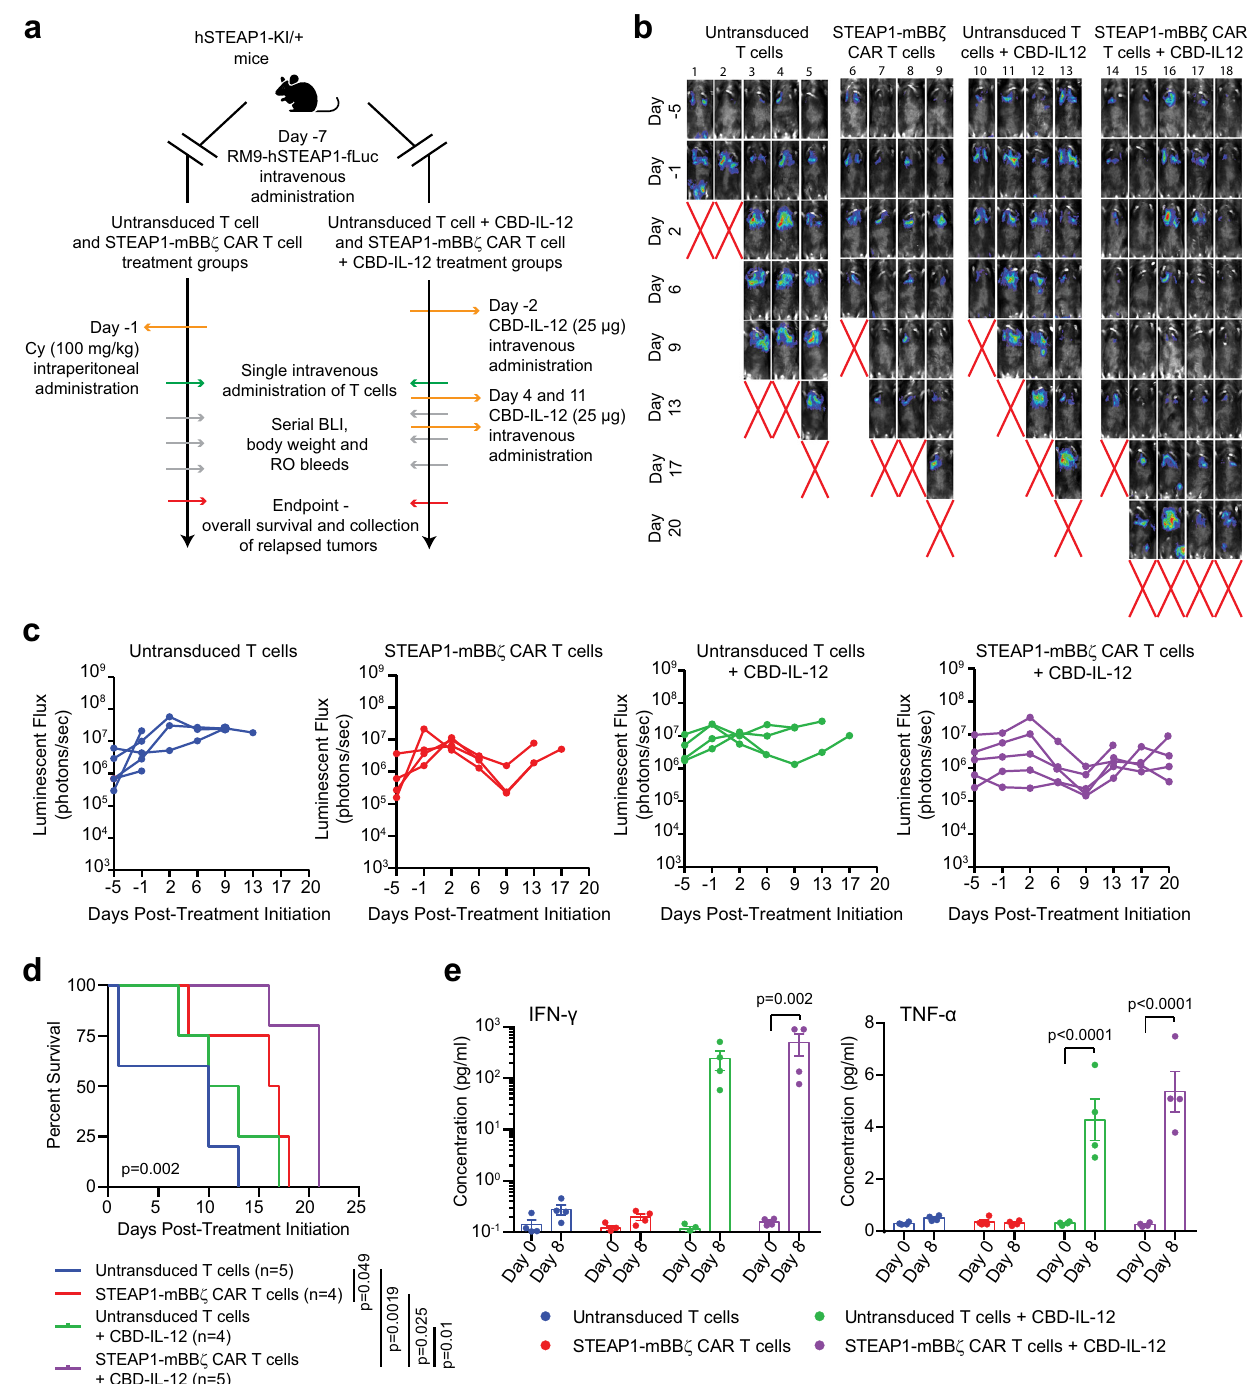
Fig. 7 | Combining CBD-IL-12 with STEAP1-mBB ζ CAR T cell therapy enhances overall survival and in fl ammatory cytokine levels. a Schematic of the tumor challenge experiment for the RM9-hSTEAP1 disseminated model in hSTEAP1-KI/+ mice investigating the combination of CBD-IL-12 with STEAP1-mBB ζ CAR T cell therapy. Cy cyclophosphamide (for preconditioning). Created with BioR- ender.com. b Serial live BLI of hSTEAP1-KI/+mice engrafted with RM9-hSTEAP1- fLuc metastases and treated with a single intravenous injection of 5×10 6 mouse untransducedTcellsorSTEAP1-mBB ζ CARTcellsonday0withorwithoutCBD-IL- 12treatmentweekly.RedXdenotesdeceasedmice.Theradiancescaleisshown.( c ) Plotshowingthequanti fi cationoftotal fl uxovertimefromliveBLIofeachmousein